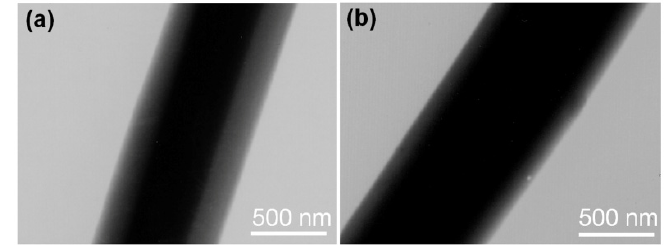
Figure 3. TEM images of the core/sheath nanocomposites: ( a ) F2 and ( b ) F3.